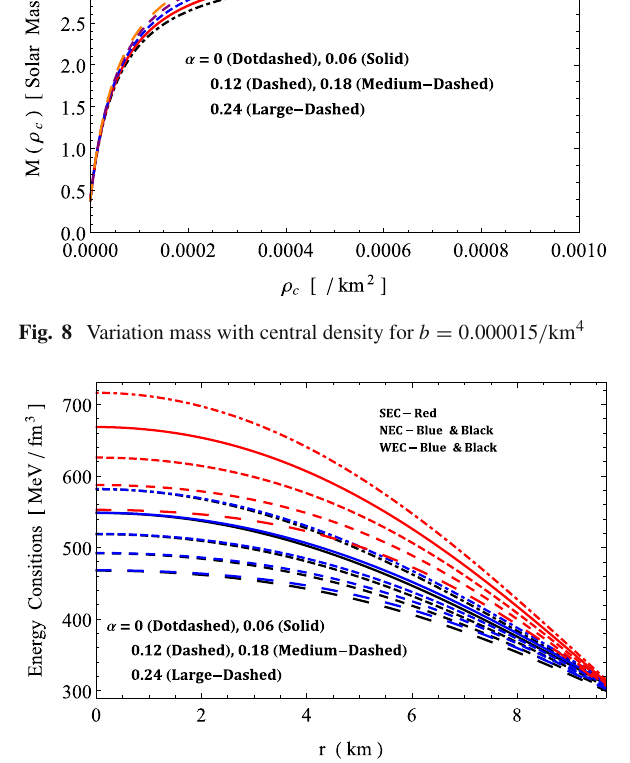
Fig. 9 Variation energy conditions with r for M = 1 . 97 M (cid:3) , R = 9 . 69 km , b = 0 . 000015 / km 4